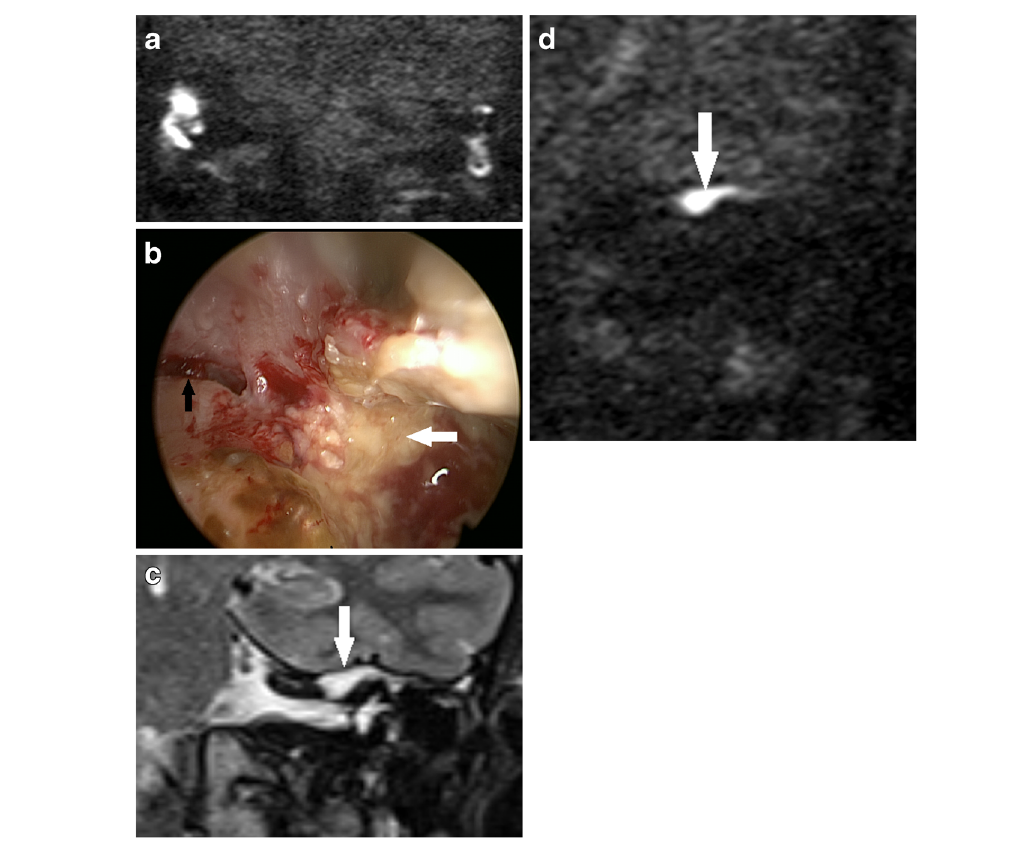
Fig. 14 Using DWI following canal wall down surgery. a DWI b1000 image depicted residual disease ( white arrow ) at the mastoid tip, also seen as low signal on the b corresponding non-contrast enhanced T1 weighted image and a heterogenous, but predominantly high signal on the c T2 weighted image. d Surgical exploration confirmed residual cholesteatoma pearl ( white arrow ) walled off in the mastoid tip and was not readily visible on direct inspection at the preceding follow-up clinic. The lesion also had low ADC signal and